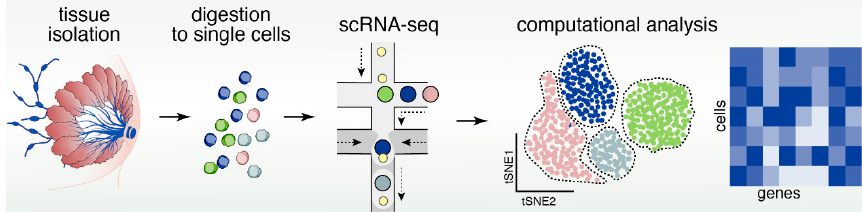
Figure 5. Pipeline of scRNAseq to resolve cellular heterogeneity with novel sequencing techniques. Processing mammary gland tissue of breast cancers into single-cell droplets coupled to single-cell RNA sequencing (scRNAseq) and data analysis (e.g., tSNE plots) allows for high resolution investigation of different cell types on the basis of individual cell transcriptome.